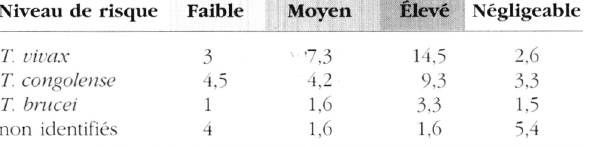
Tableau VIII. - Pourcentage de réactions PCR positives par rapport au nombre de glossines disséquées.